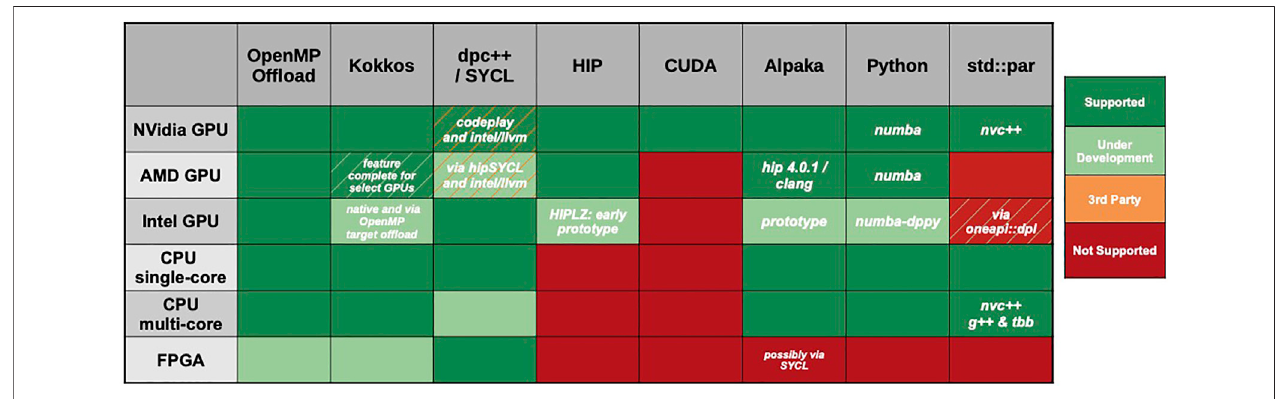
FIGURE 4 | Portability solutions for heterogeneous